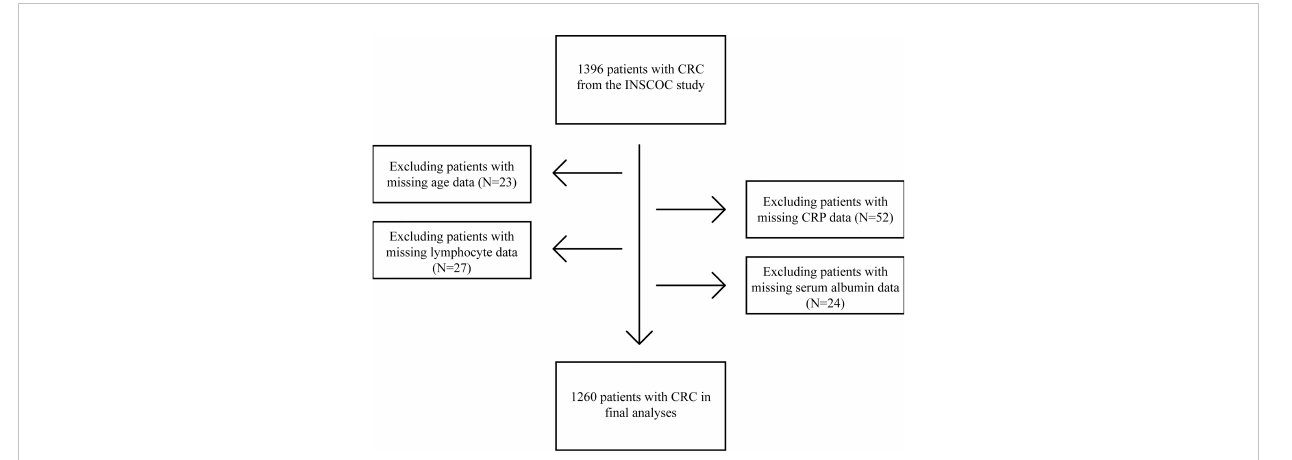
FIGURE 1 Procedures for selection of study participants with CRC from the INSCOC study. CRC, colorectal cancer; INSCOC, Investigation on Nutrition Status and Clinical Outcome of Common Cancers; CRP, C-reactive